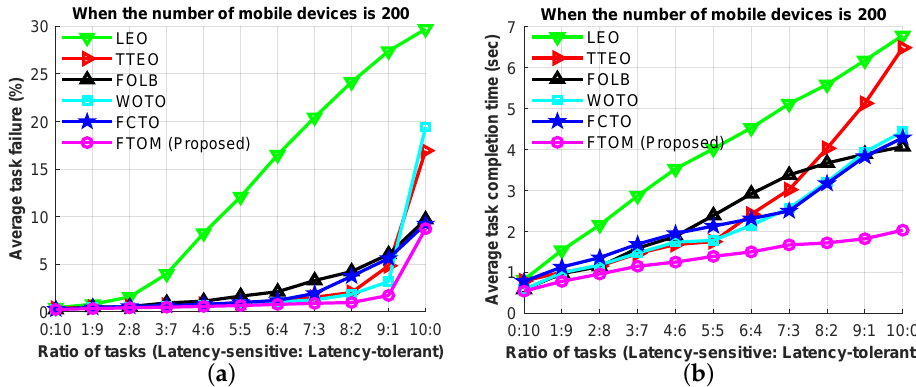
Figure 13. Performance analysis based on latency-sensitive to latency-tolerant task ratio: ( a ) average task failure rate; ( b ) average task completion